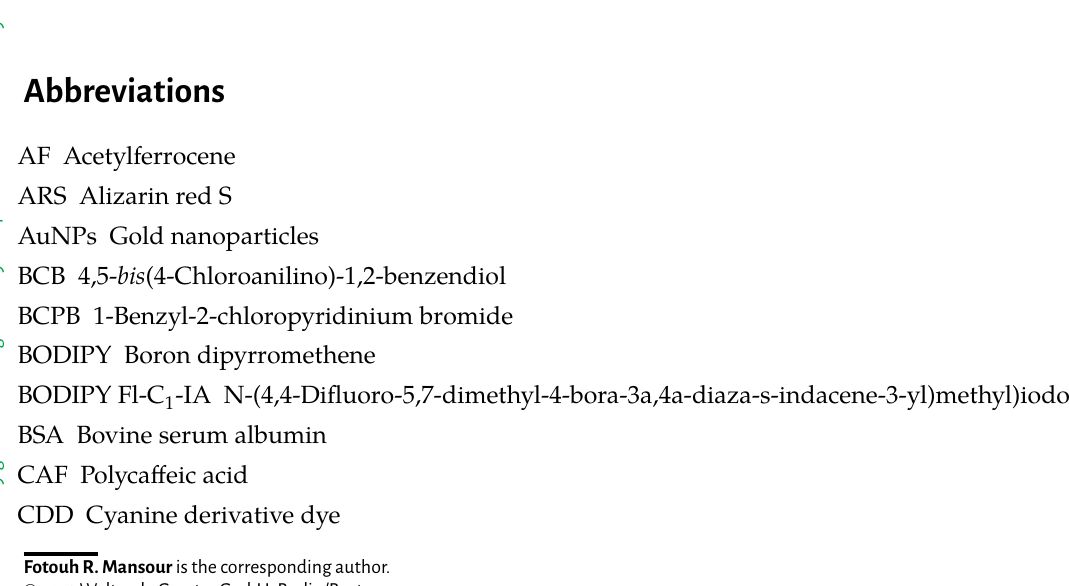
FotouhR.Mansour isthecorrespondingauthor.